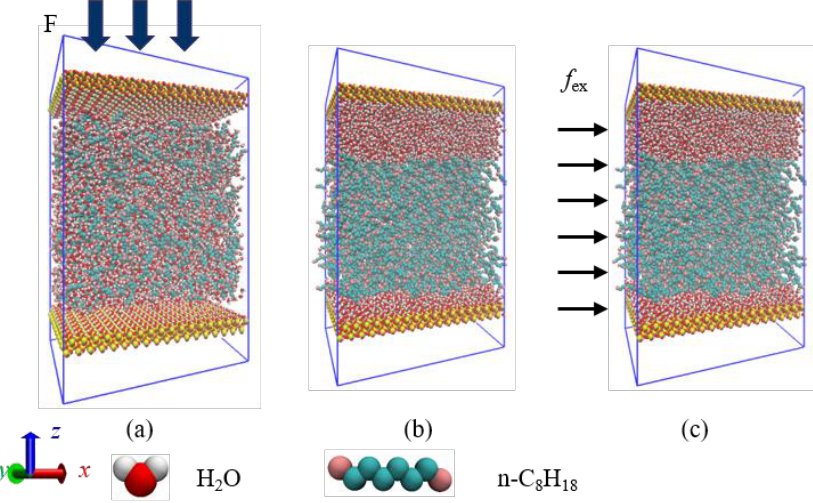
Figure 2. The process of the molecular simulation: ( a ) initial configuration and pore pressure control, ( b ) equilibrium configuration, ( c ) flow simulation.